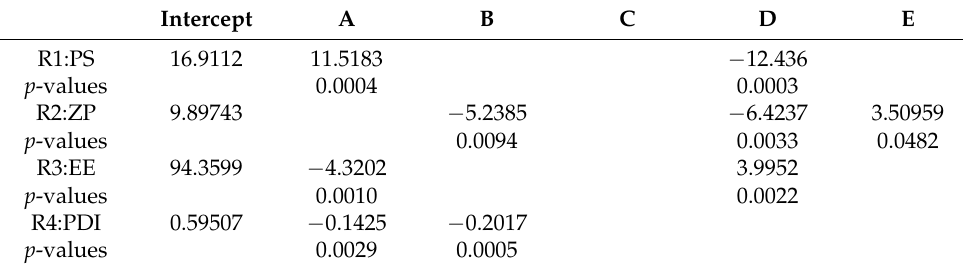
Table 3. Coefficients and ANOVA results for the effects of the studied screening